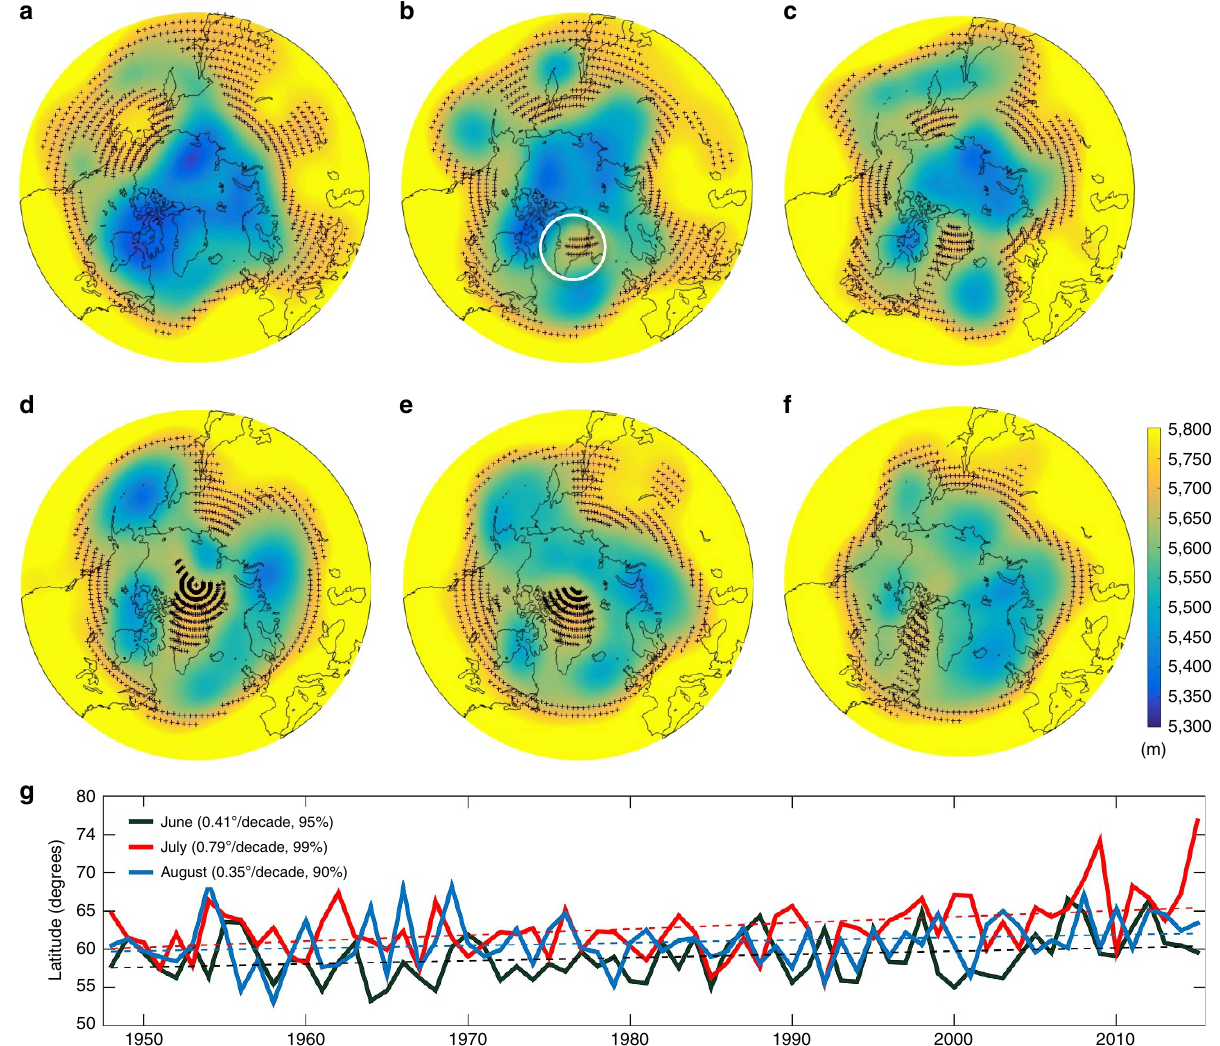
Figure 2 | Spatial and temporal evolution of the jet stream conditions and wave amplitude. Jet stream is here characterized through the 5,700 ± 50m 500hPa isoheights 13 . ( a – f ) Five day average geopotential height (m) at 500hPa for the period 18th June to 22nd July 2015. For each day, the daily averaged values for the 2 days before and after were averaged with the daily average value of that day. Crosses show the locations where geopotential height values are 5,700 ± 50m. ( g ) Maximum latitude of ridge peaks computed from the 500hPa 5,700 ± 50m isoheight for the period 1948–2015 over the region bounded between 45–85 (cid:2) N and 100 (cid:2) W–0 (cid:2) E (included in the area marked by the dashed lines in Fig. 1b), averaged over the months of June (black), July (red) and August (blue). Linear trends and significance levels are reported in the